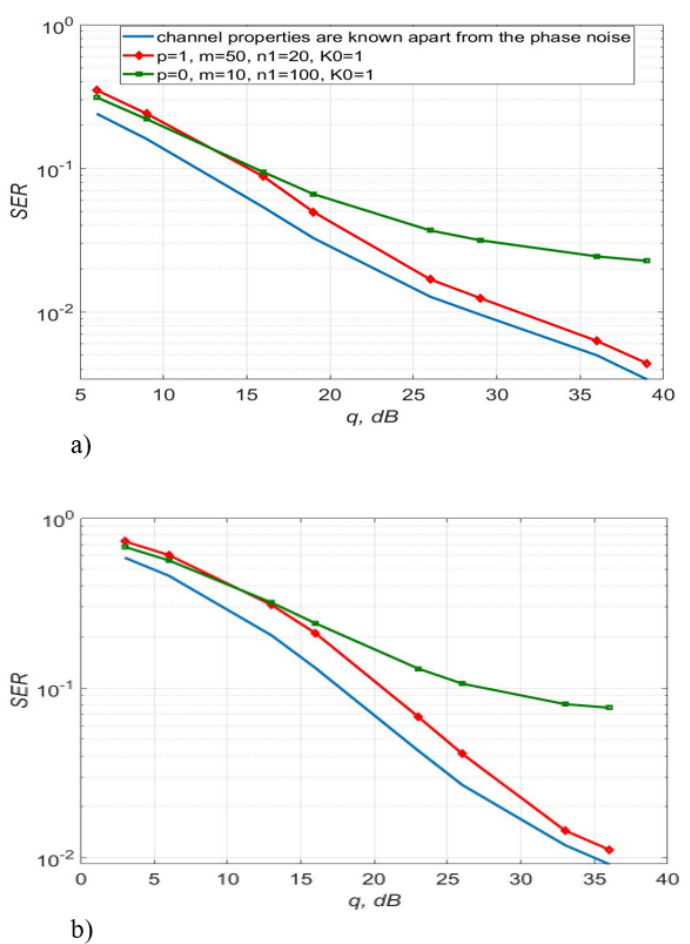
Figure 6. SER of 16-QAM—( a ), 64-QAM—( b ) versus SNR for the algorithms, described by Equations (5)–(9) and (12) with polynomial approximation of zero and the first order.